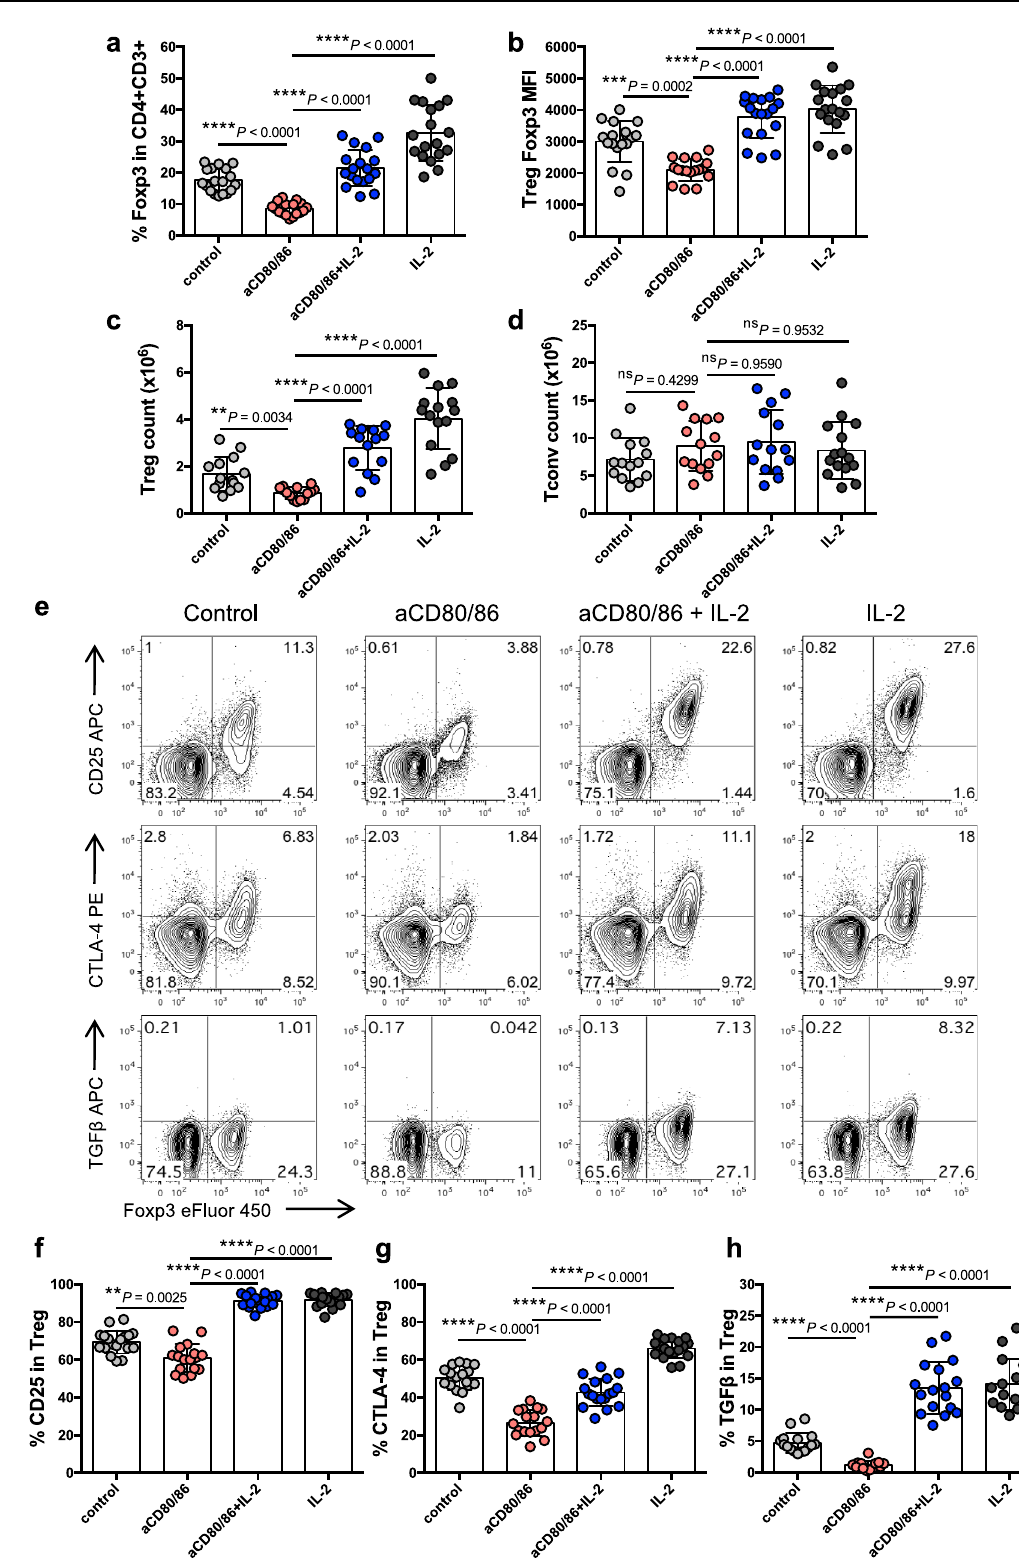
Fig. 3 | IL-2 can compensate for CD28 blockade in Treghomeostasis. 7 – 15 week old BALB/c mice were injected i.p. with control Ab, anti-CD80/86Ab, IL-2 complex or both anti-CD80/86 Ab and IL-2 complex as indicated (anti-CD80/86 Ab was injectedond0andd6;IL-2complexwasinjectedond0,d2,d5andd7).Spleencells were analysed at d8. Graphs show collated data for Treg percentage in gated CD4+CD3+cells a ,TregFoxp3MFI b ,Tregabsolutenumber c ,andTconvabsolute number d .RepresentativeFACSplots e ,andpooled datadepictTregexpressionof